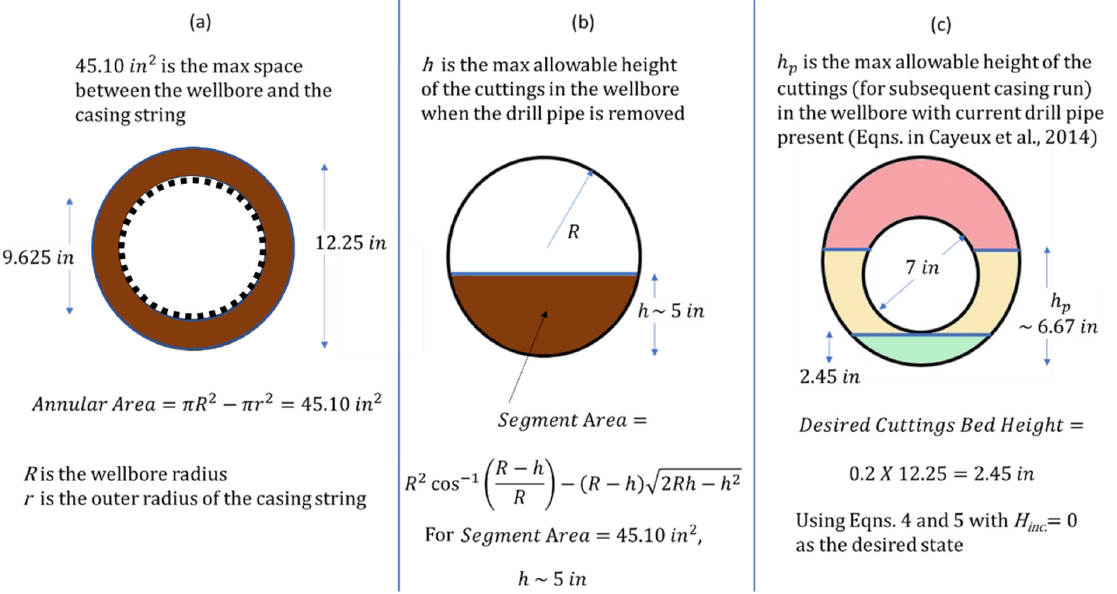
Figure 12. The theoretical limit of allowed cuttings bed height for the given well profile. ( c ) Equations in [31].